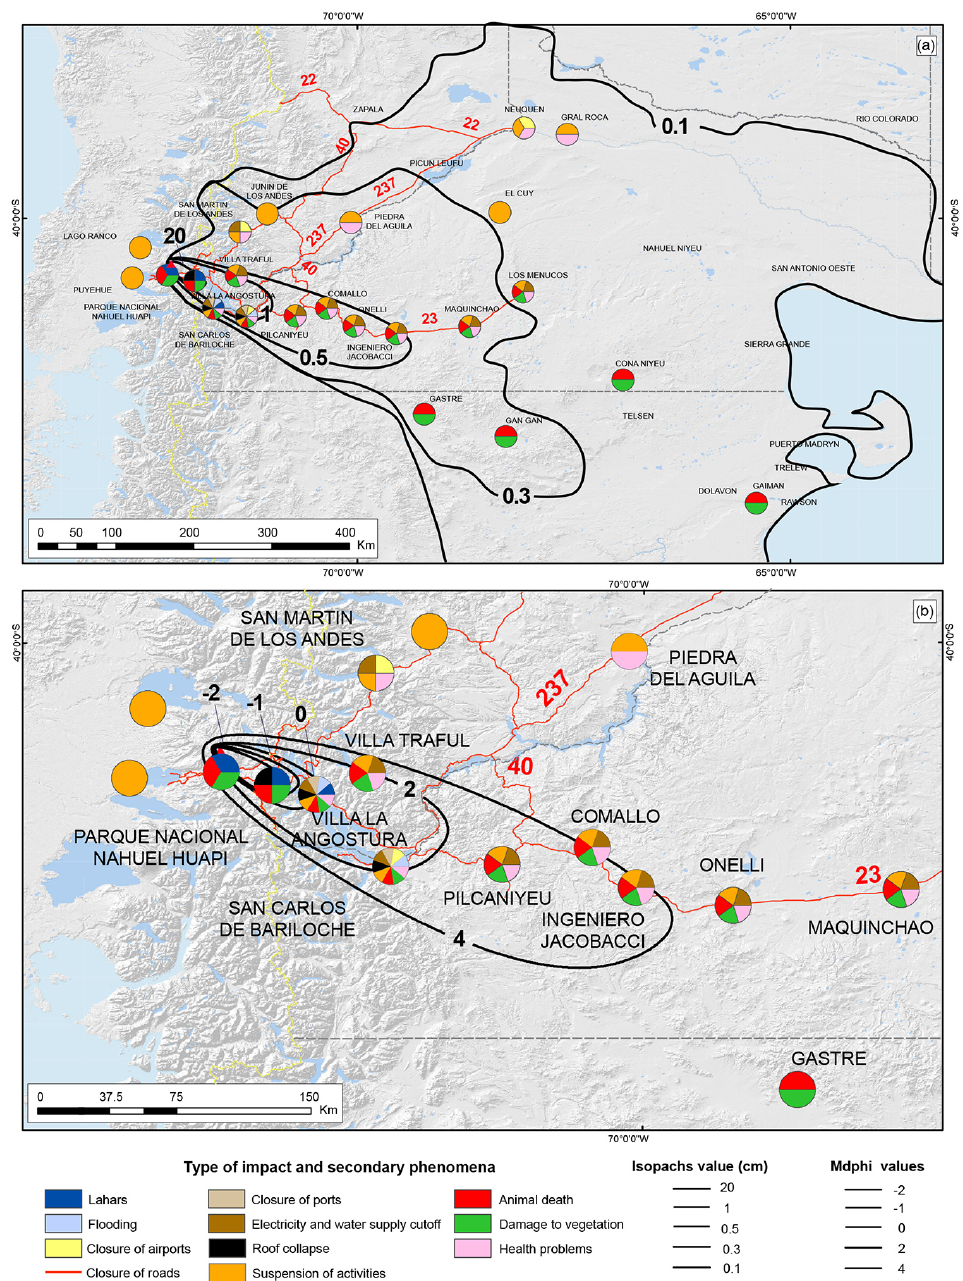
Figure 9. Distribution of the different impact types and secondary phenomena (indicated in the pie charts) associated with various localities in Argentina (southeast Río Negro, South Neuquén and north of Chubut provinces) and Chile (Lago Ranco and Puyehue areas). (a) Isopach lines of unit I are shown as solid lines from 20 to 0.5cm (Pistolesi et al., 2015); isolines of 0.3 and 0.1cm are associated with the whole deposit observed by Gáitan et al. (2011). (b) Solid lines represent the median diameter (Mdphi) for unit I (Bonadonna et al.,